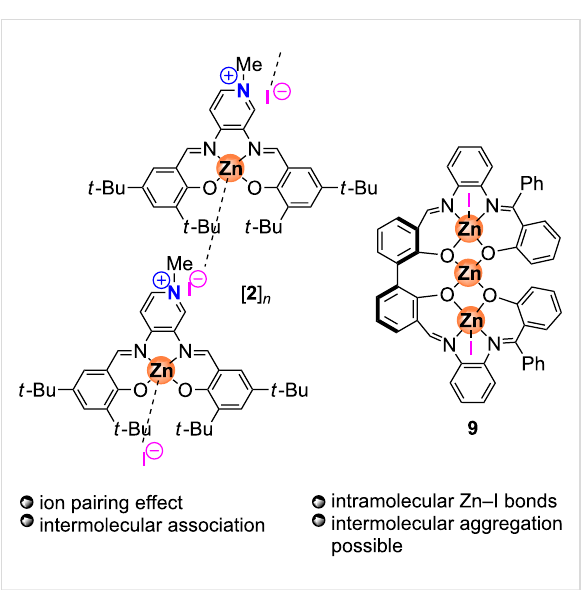
Figure 7: Proposed association for complex 2 and schematic struc- ture for bifunctional complex 9 .